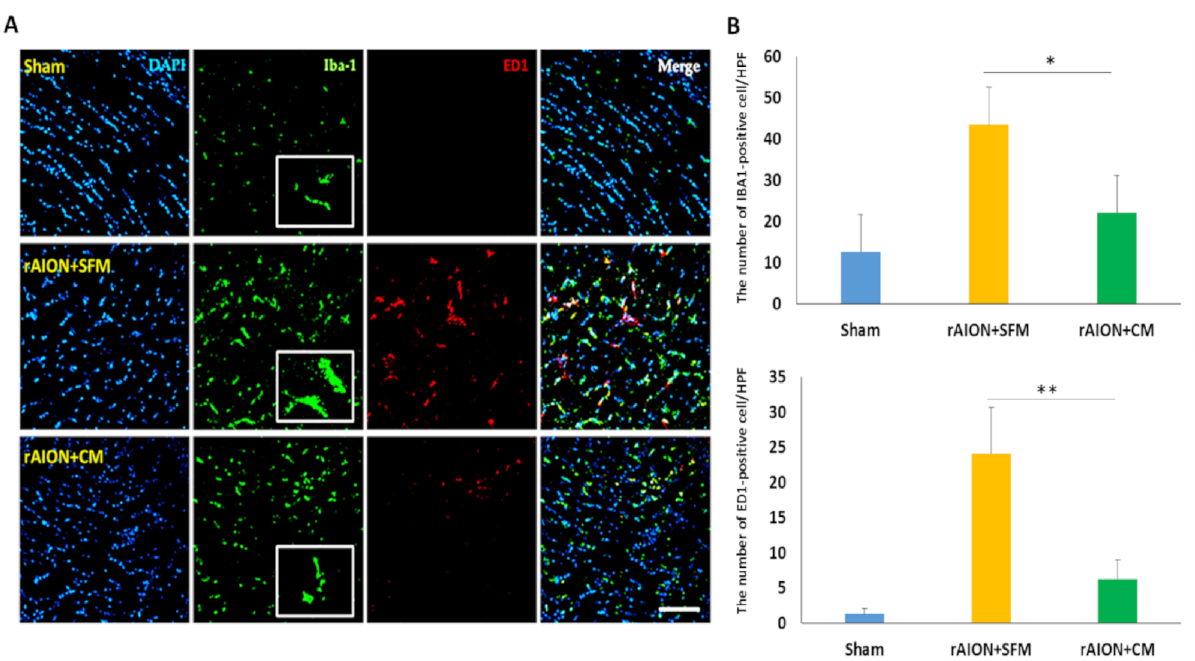
Figure 8. Microglia activation and macrophage infiltration in the optic nerve after ON infarct. ( A ) representative image of Iba1 and ED1 staining in longitudinal sections of the ONs. The Iba1-positive cells, the ED1-positive cells, and the nuclei are marked in green, red, and blue colors, respectively; Treatment with CM effectively reduced the size of the microglia cell (Iba1-positive cell) in contrast to treatment with SFM four weeks after ON infarct. ( B ) Quantification of Iba1+ and ED1+ cells per high-power field (HPF). Data are expressed as mean ± SD ( n = 6 per group). The decreasing number of Iba1+ cells was significantly different in the CM-treated group as compared to in the SFM-treated group ( n = 6 per group). The number of macrophages (ED1-positive cells) in the CM-treated group was lower than that in the SFM-treated group ( n = 6 per group). Scale bar: 100 µ m. * p < 0.05. ** p < 0.01. Iba1: ionized calcium binding adaptor molecule 1; ED1: